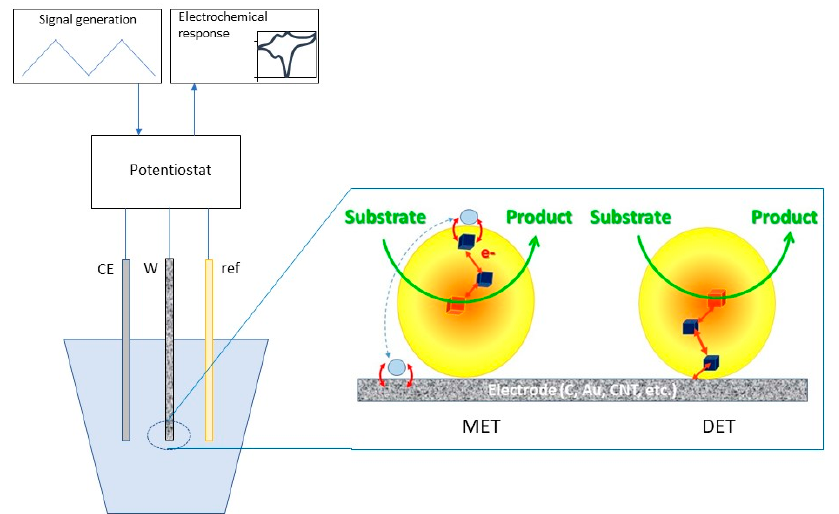
Figure 10. Scheme of a typical bioelectrochemical experiment showing the set up and the adsorp- tion of a protein on the electrode surface either in a MET or a DET mode. The active site of the enzyme, the electronic relays and the redox mediator are represented as red squares, dark blue squares, and light blue spheres, respectively. CE, W, and ref represent counter, working, and reference electrodes, respectively.